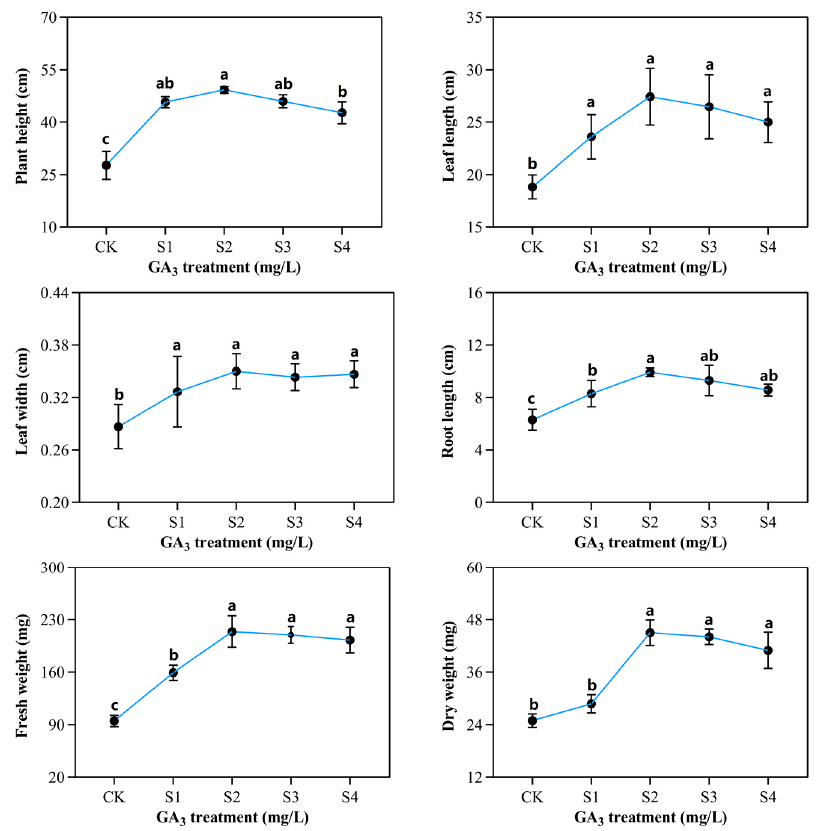
Figure 2. The outcome of varying exogenous GA 3 concentrations on the phenotypic variations of sorghum seedling development under 150 mM NaCl exposure. CK—0 mg/L GA 3 ; S1—25 mg/L GA 3 ; S2—50 mg/L GA 3 ; S3—75 mg/L GA 3 ; S4—100 mg/L GA 3 . Six sorghum plants from GA 3 treatment (n = 3) and the control group (n = 3) were used for phenotypic determination, including plant height, leaf width, fresh weight, leaf length, root length, and dry weight. All data are presented as the mean ± SD, Superscript different lowercase letters means significant difference ( p < 0.05), Superscript same lowercase letters means significant difference showed no significant difference ( p > 0.05).